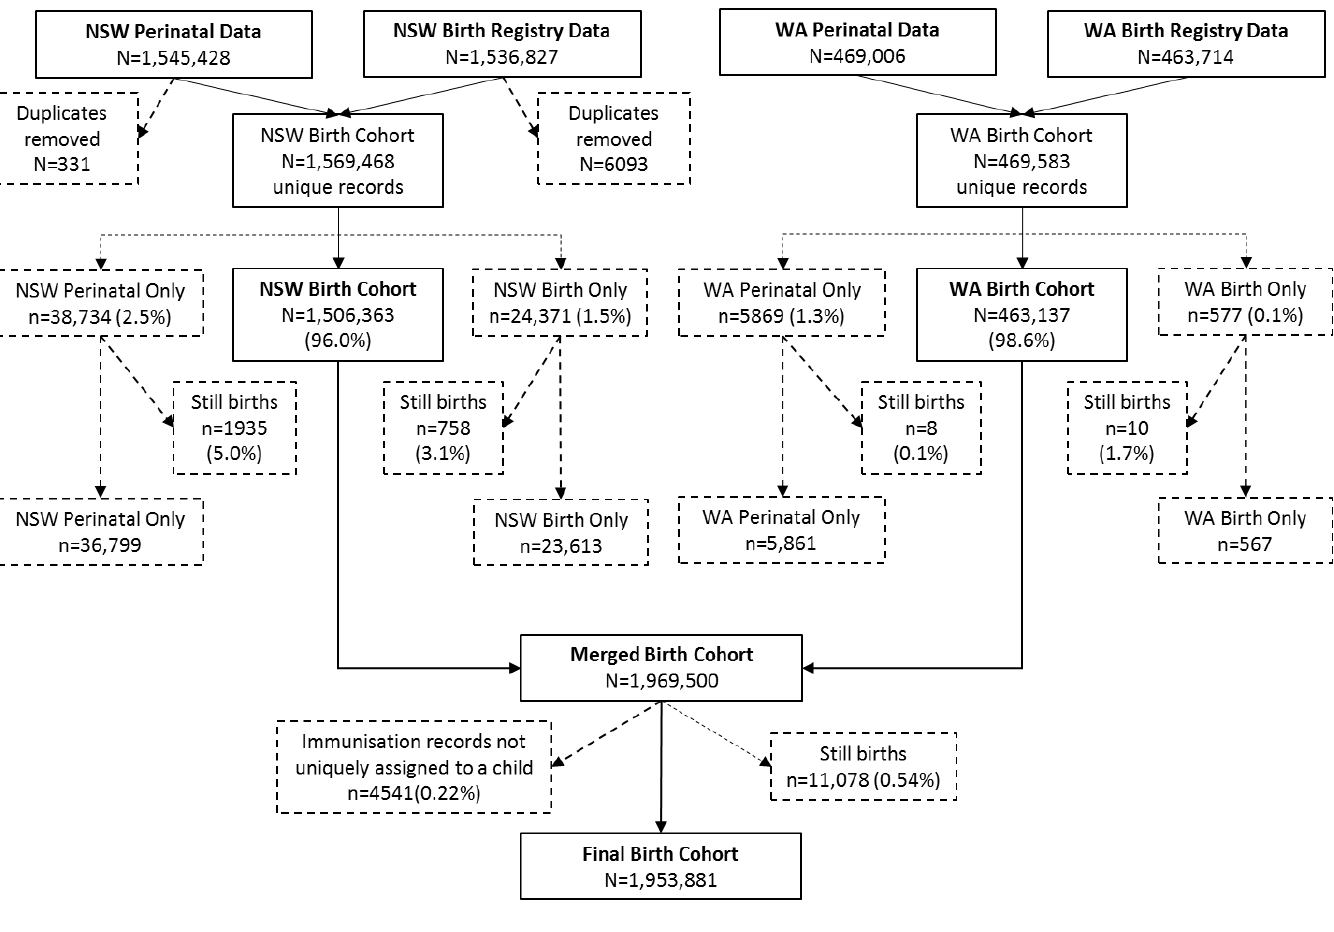
Figure 2: Flowchart of the assembly of the study birth cohort showing